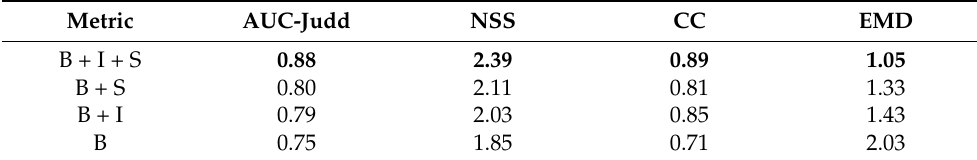
Table 3. Quantitative results of model ablation on the Cat2000 validation dataset.